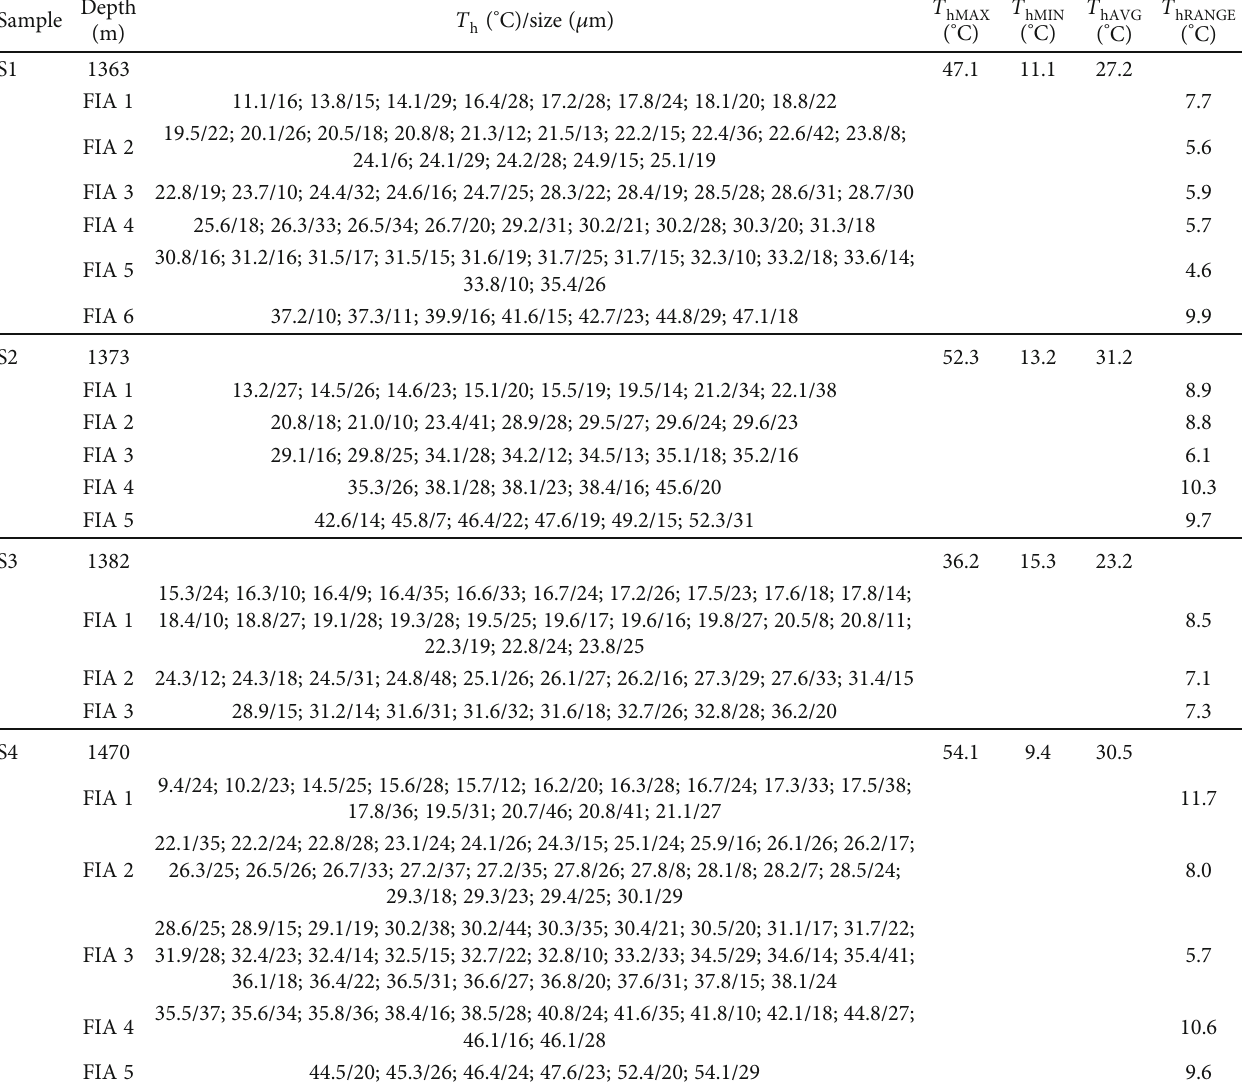
° C) of middle Eocene halite primary fl uid inclusions in borehole DZK01, Kuqa Basin. Table 1: T h ( Depth Sample